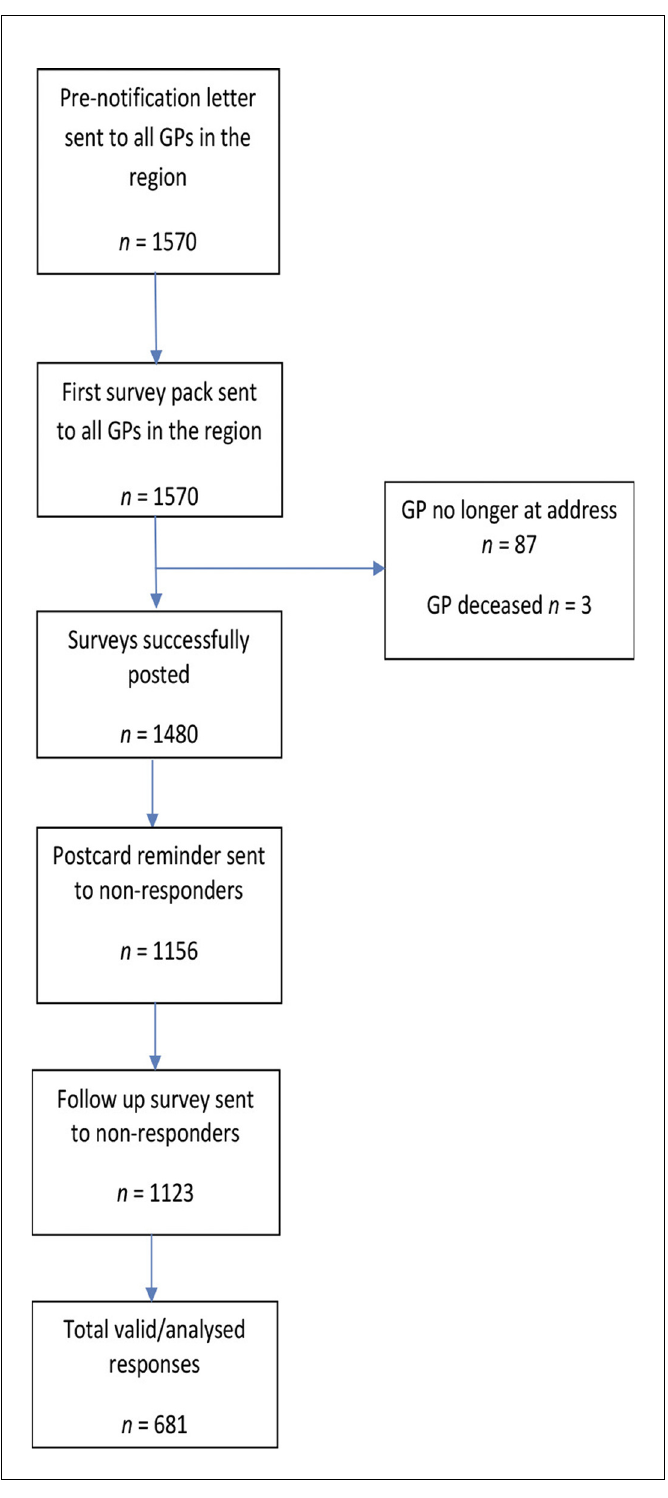
Figure 1. Survey recruitment